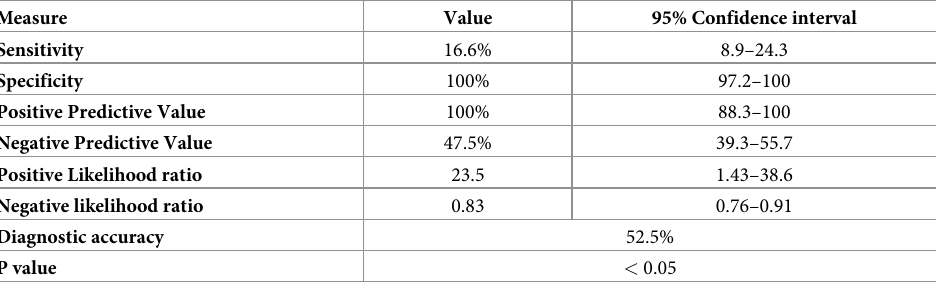
Table 3. Diagnostic measures of GXpert assay in detecting tubercular pleural effusion as compared to composite reference standard (N =